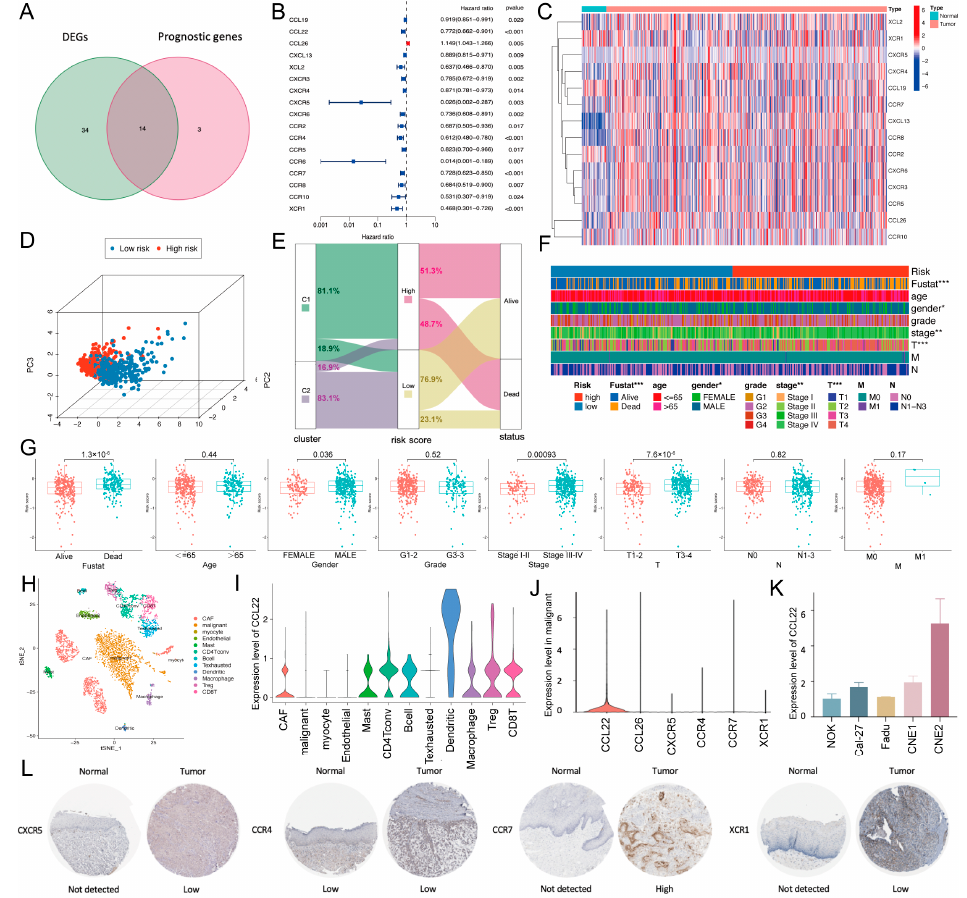
Figure 3. Establishment and validation of the risk model. ( A ) Venn diagram to identify DEGs related to prognosis. ( B ) Hazard ratio of the prognostic genes. ( C ) Heatmap of the overlapping genes. ( D ) PCA analysis showed a remarkable difference between the low- and high-risk groups. ( E ) Alluvial diagram of cluster distributions in groups with different risk scores and survival status. ( F ) Different clinicopathological features of the two risk groups. ( G ) The risk score in different groups was divided by clinicopathological features. ( H ) t-SNE classified cell clusters based on transcriptome data. ( I ) Expression level of CCL22 among 12 cell types in scRNA-seq. ( J ) Expression levels of the six risk genes in malignant cells in scRNA-seq. ( K ) Relative expression levels of CCL22 in five cell lines by RT-qPCR. ( L ) The protein expression levels in the HPA database (CCL22 and CCL26 not found). ns, p > 0.05, * p < 0.05, ** p < 0.01, *** p < 0.001.